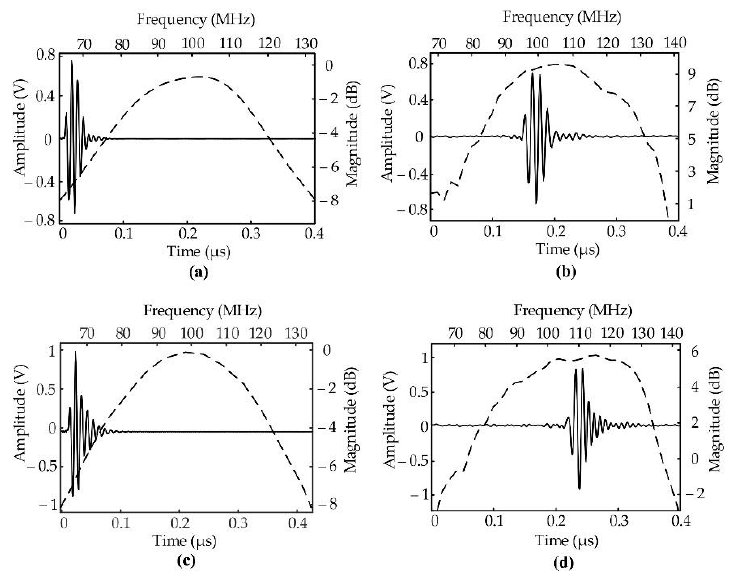
Figure 4. Pulse–echo response (solid line) and frequency spectra (dashed line) for a focused needle Figure 4. Pulse – echo response (solid line) and frequency spectra (dashed line) for a fo- transducer with 1.5 mm of focal length. ( a ) Simulated signals and ( b ) measured signals of 103 MHz cused needle transducer with 1.5 mm of focal length. ( a ) Simulated signals and ( b ) meas- PMN-0.3PT transducer with 52 % BW at − 6 dB and a 10 µ m thickness. ( c ) Simulated signals and ured signals of 103 MHz PMN-0.3PT transducer with 52 % BW at − 6 dB and a 10 µm ( d ) measured signals of 105 MHz LiNbO 3 with 66% BW at − 6 dB and a 28 µ m thickness. ( c ) Simulated signals and ( d ) measured signals of 105 MHz LiNbO 3 with 66% BW at − 6 dB and a 28 µm thickness.